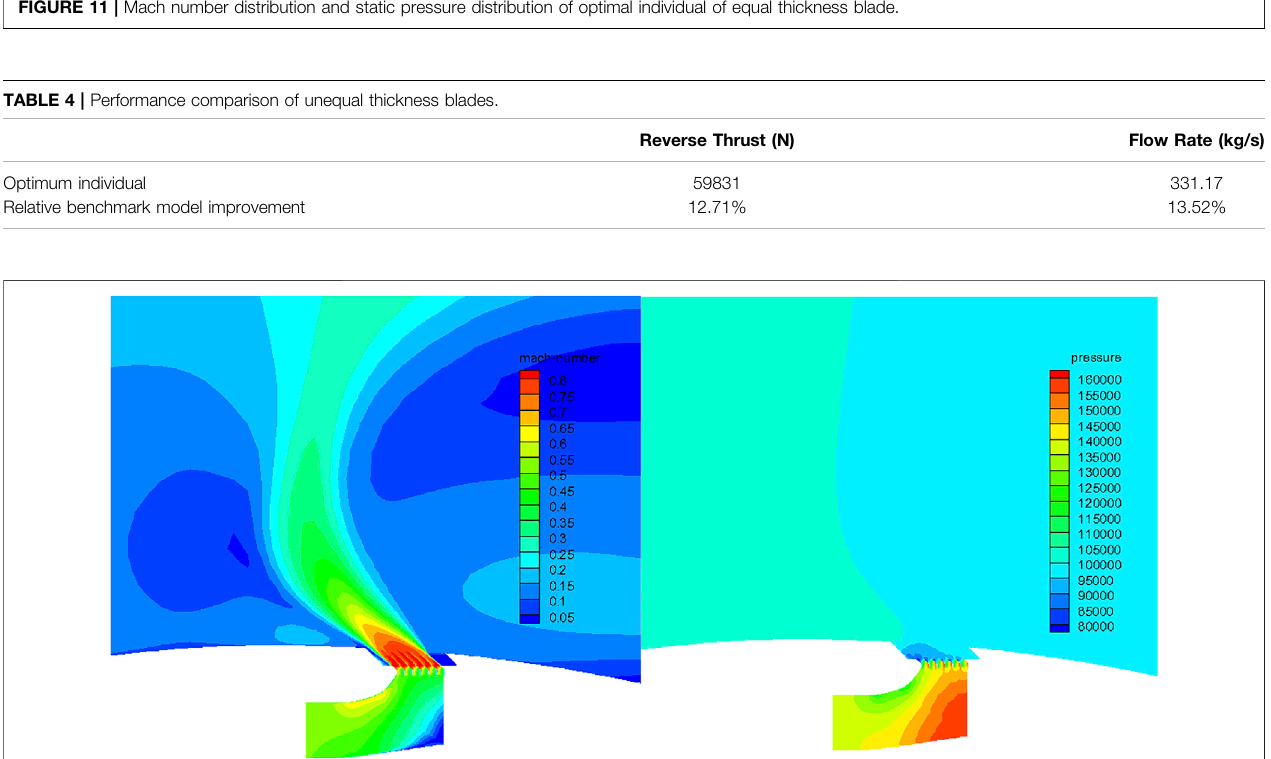
FIGURE 12 | Mach number distribution and static pressure distribution of the optimal individual of unequal thickness blades.